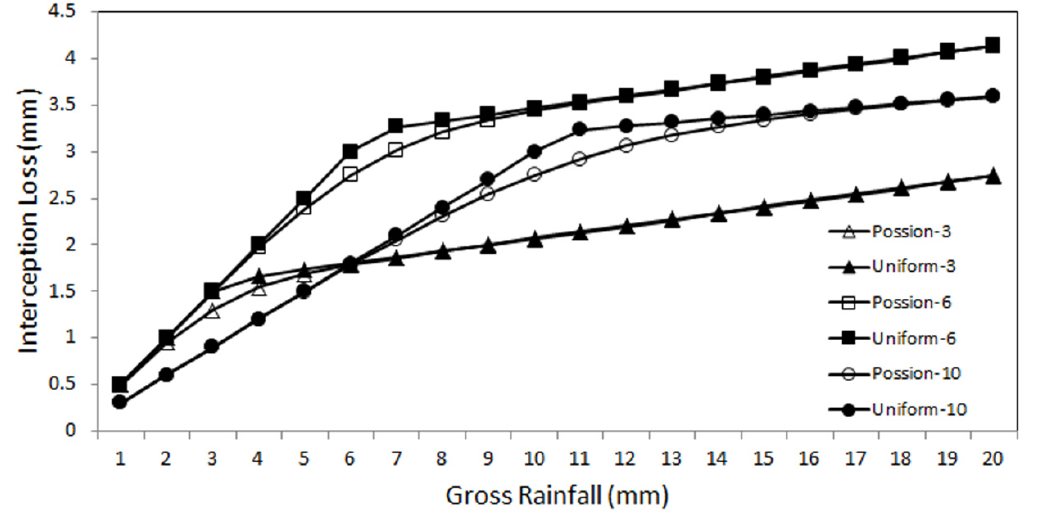
Figure 7. The results of interception loss vs. gross rainfall between Poisson distribution and uniform distribution, where S · VAI / FVC is equal to 3 (mm), 6 (mm) and 10 (mm) V